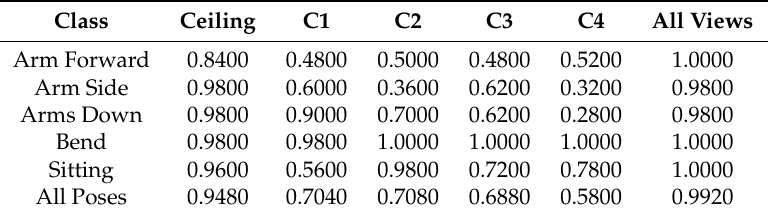
Table 3. Recall results from the five TISs test where C = corner.